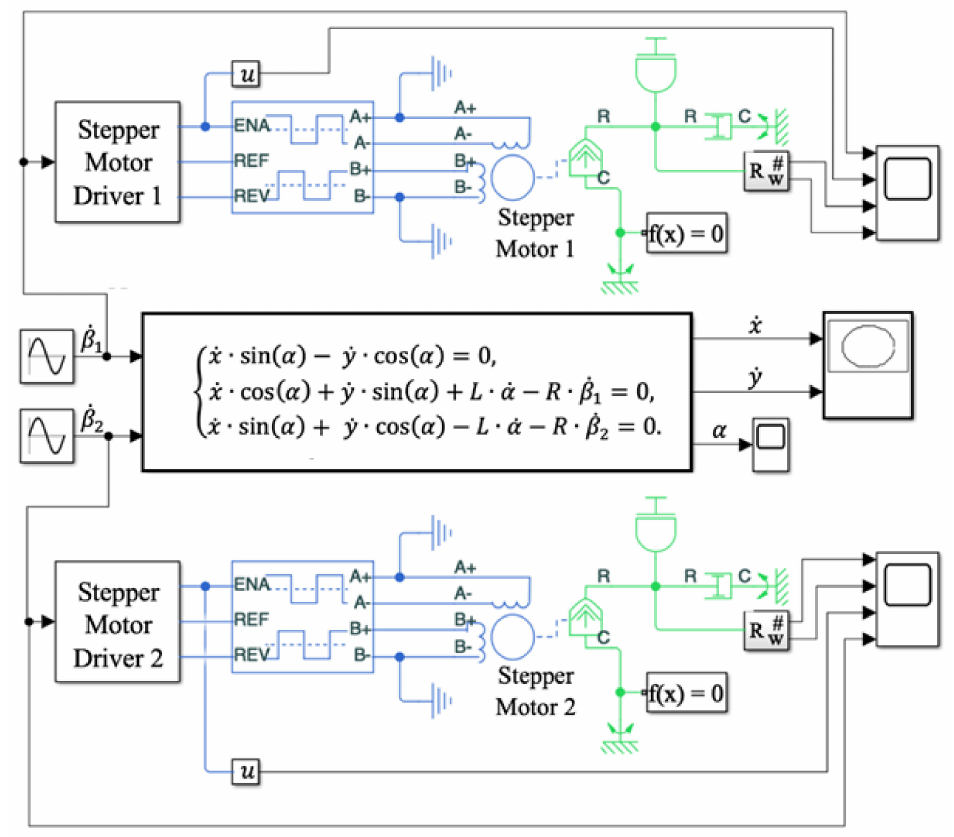
Figure 5. Mathematical model of the feed pusher robot.